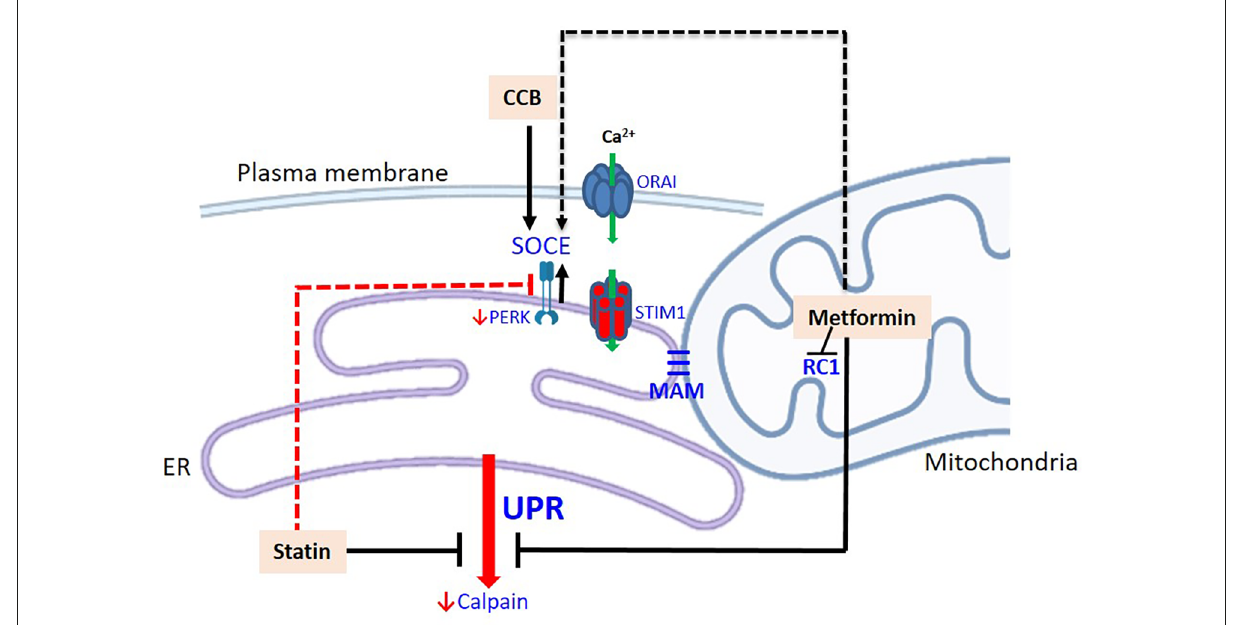
FIGURE3 Modulation of the UPR by drugs prescribed for patients with diabetes mellitus. Metformin inhibits the respiratory chain complex 1 (decreasing ROS) and consequently the efflux of Ca 2+ from the ER. This could potentially stimulate Ca 2+ entry via SOCE. Statins down-regulate the expression of CBP chaperones of the ER, calpains, and PERK. Potentially, statins have a dual role, as downregulation of PERK can decrease Ca 2+ entry into the ER, via SOCE. CCB stimulates STIM-1 and increase the input of Ca 2+ to the ER. The dashed routes refer to potential pathways and their effects on neural cells, particularly astrocytes, need to be confirmed. Abbreviations: CCB, calcium channel blockers; MAM, mitochondria-associated ER membrane; RC1, respiratory chain complex 1; STIM-1, stromal-interacting molecule